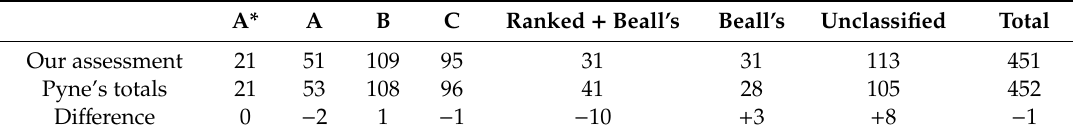
Table 1. Journal rankings by Pyne versus our